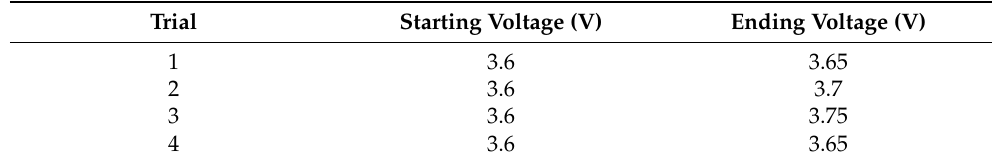
Table 4. Test results for Cell 2 with transfer learning applied.